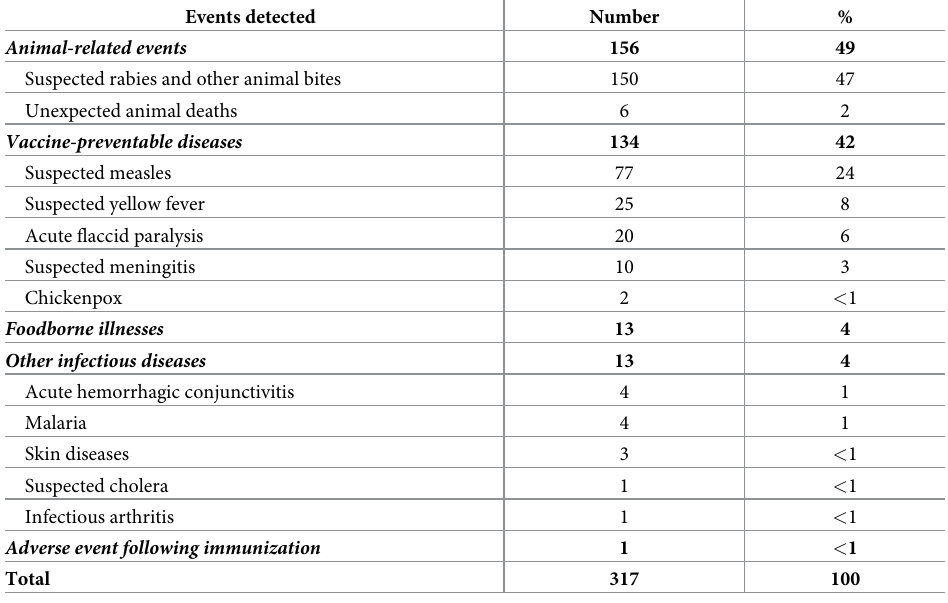
Table 2. Type of events detected during Phase II modified CBS implementation, September 2018–March